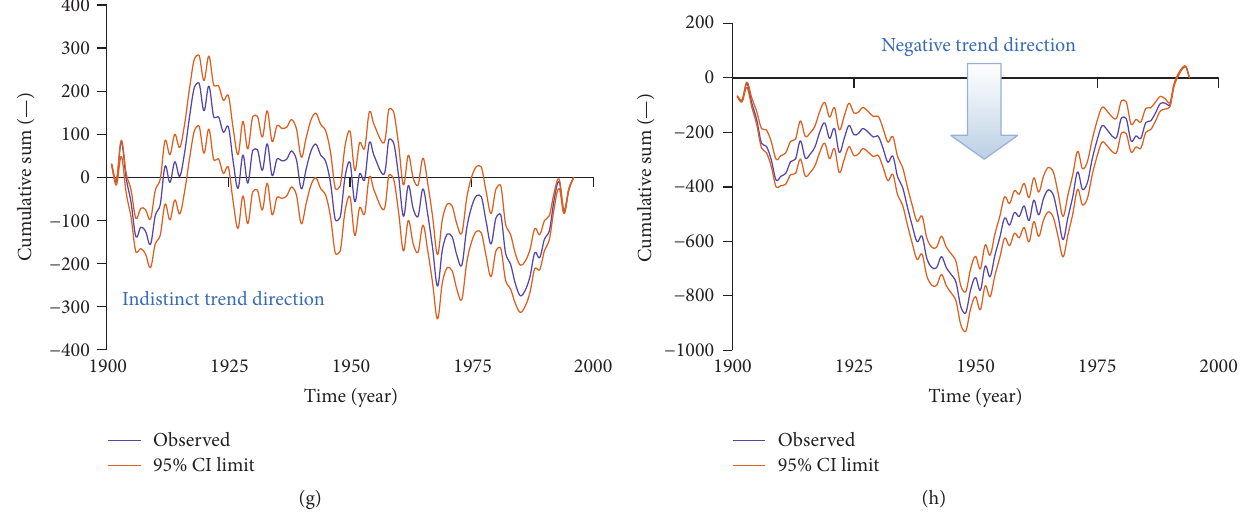
Figure 2: Time series plots for the nonparametrically rescaled annual rainfall at station: (a) 4, (b) 10, (c) 12, and (d) 17. The corresponding CRD plots for the series in (a)–(d) are in (e)–(h), respectively.